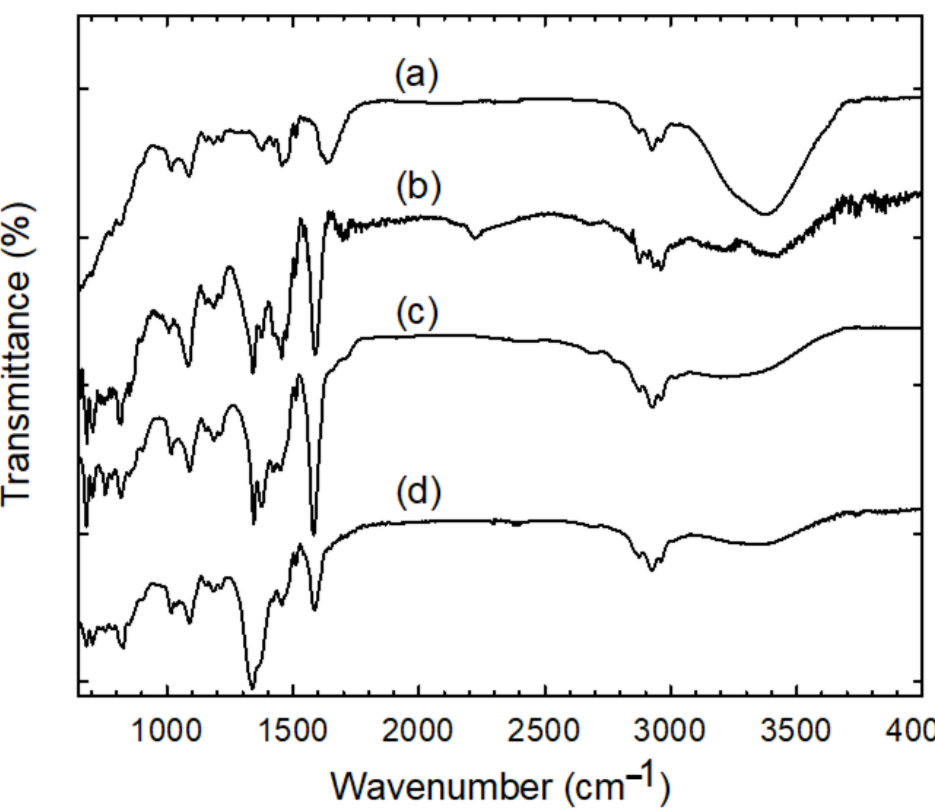
Figure 5. A comparison of FTIR spectra of the pure resin in chloride form ( a ) and those loaded with silver particles using increasing AgNO 3 concentrations of 1 mM ( b ), 10 mM ( c ), and 50 mM ( d